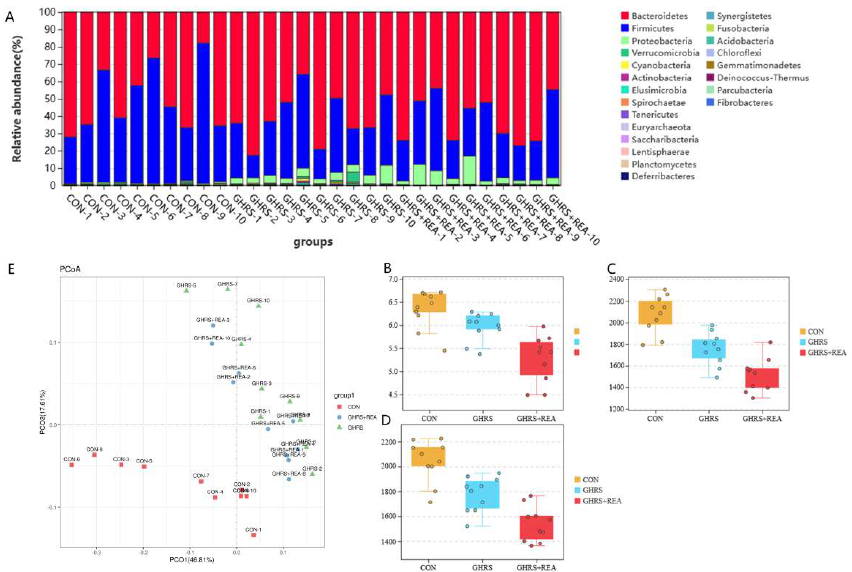
Figure 7. The composition of fecal microorganism in the indicated groups. ( A ) The dominant bacteria in each group. ( B – D ) The Shannon index, Chao1 index, and ACE index of microbiota for each group. ( E ) The PCoA analysis of microbiota in the indicated groups.